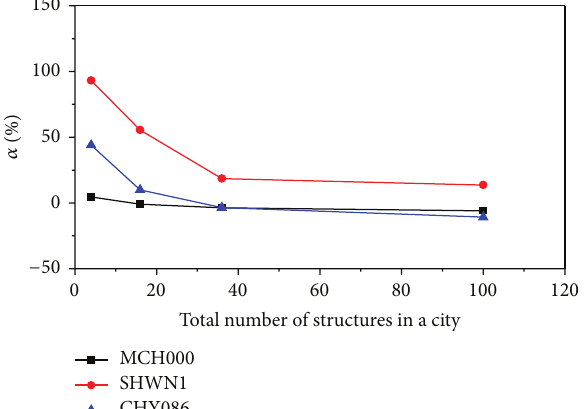
Figure 12: Site seismic response in terms of coefficient 𝛼 with respect to the number of structures in the urban area ( 𝐷 = 0.5 , 𝑆𝑋